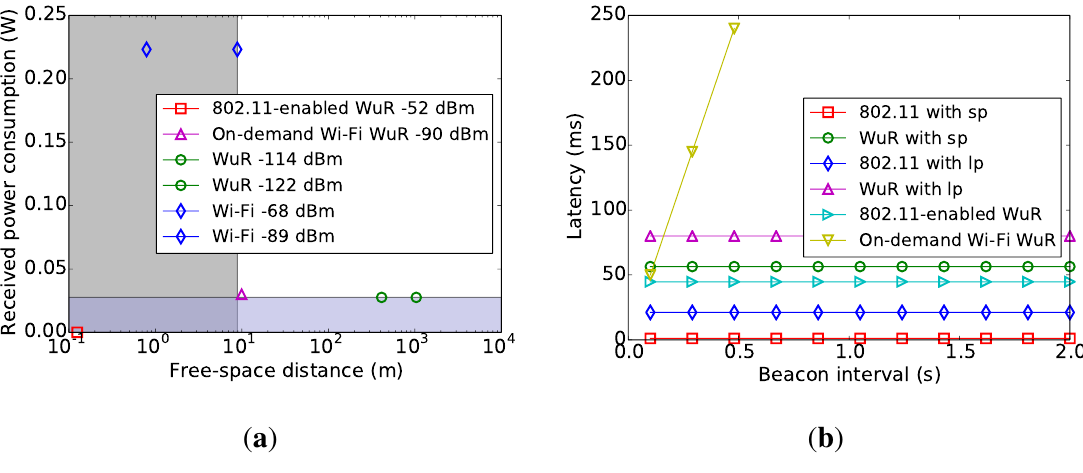
Figure 9. Performance comparison of our LDWuR with existing WuRs. ( a ) Received power consumption versus free-space distance; ( b ) latency versus beacon